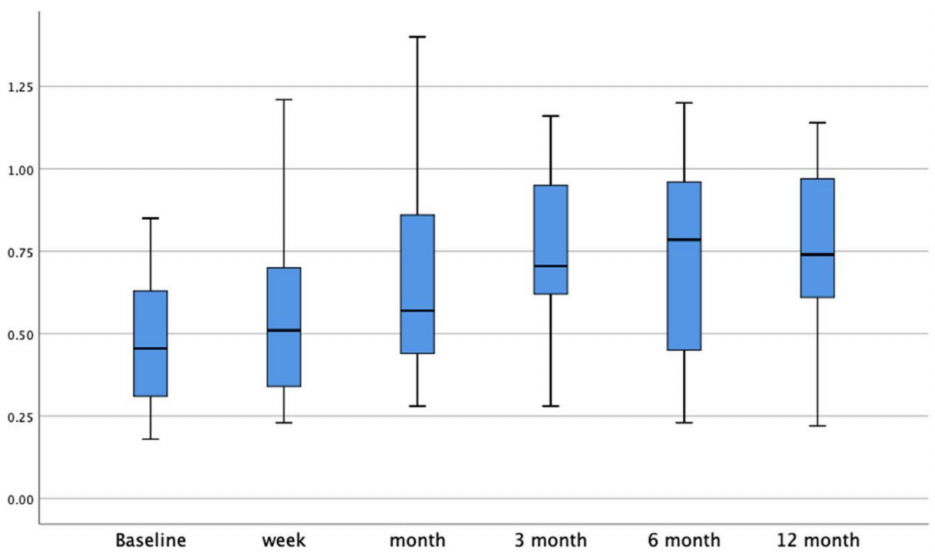
Figure 1. Bar graphic showing the HC gain values at every follow